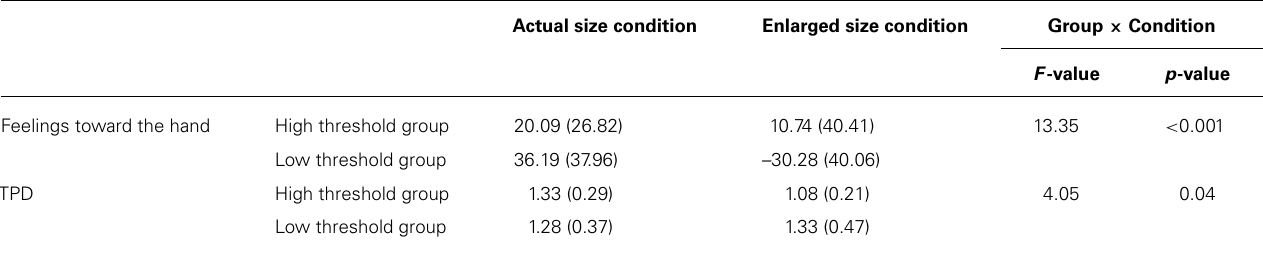
Table 2 | Comparison ofTPD and Feeling toward the hand under actual size and enlarged size conditions between the high threshold and low threshold